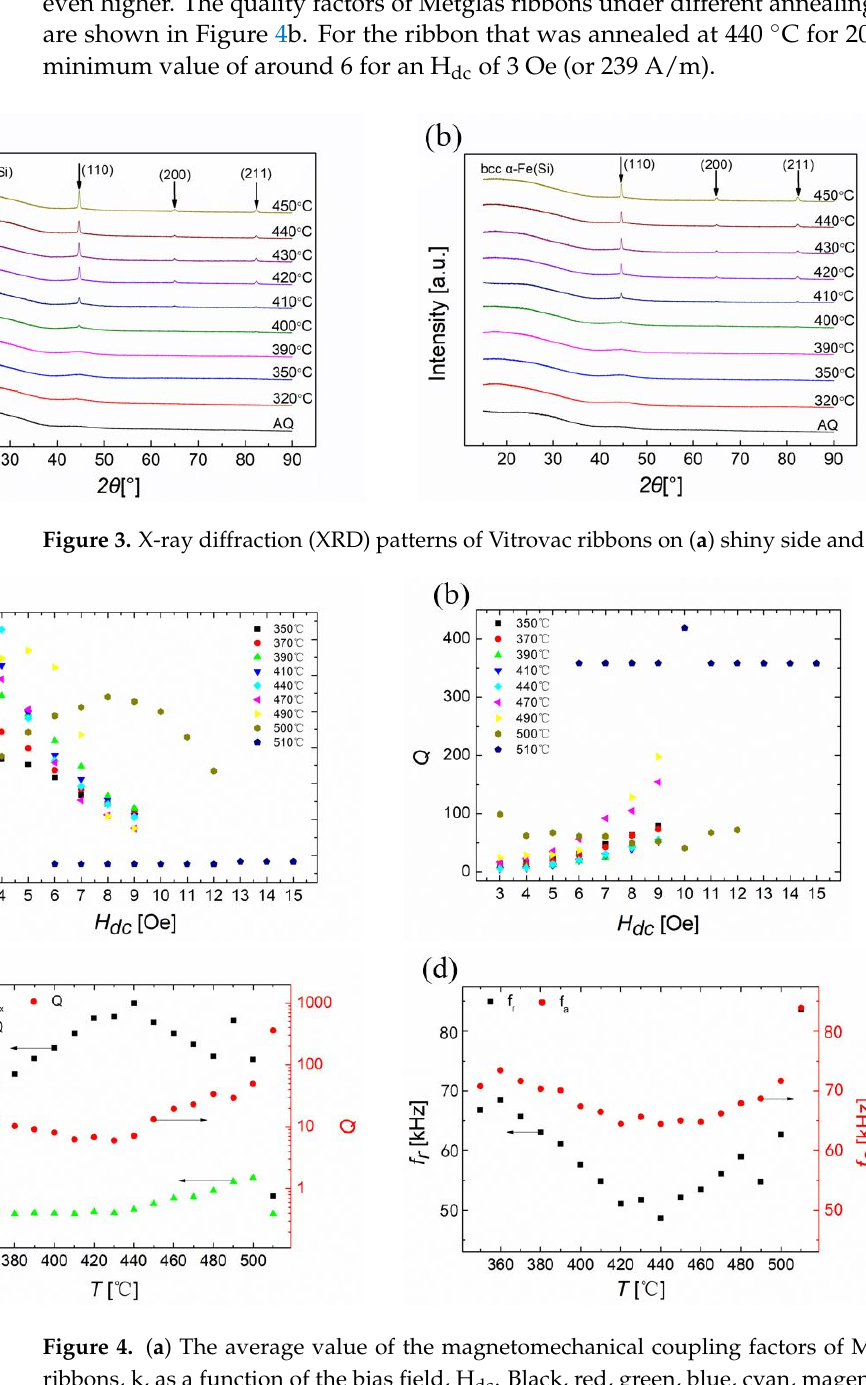
Figure 4. ( a ) The average value of the magnetomechanical coupling factors of Metglas 2605SA1 ribbons, k, as a function of the bias field, H dc . Black, red, green, blue, cyan, magenta, yellow, dark yellow, and navy curves are annealed at 350 °C, 370 °C, 390 °C, 410 °C, 440 °C, 470 °C, 490 °C, 500 °C, and 510 °C for 20 min, respectively. ( b ) The average value of the quality factors of Metglas ribbons, Q, as a function of the bias field, H dc . Black, red, green, blue, cyan, magenta, yellow, dark yellow, and navy curves are annealed at 350 °C, 370 °C, 390 °C, 410 °C, 440 °C, 470 °C, 490 °C, 500 °C, and 510 °C for 20 min, respectively. ( c ) The maximum value of coupling coefficient of Metglas ribbons, k, as a function of the annealing temperature, T. The green and red curves represent the values of the quality factors and efficiency coefficients corresponding to the maximum values of coupling coefficients, respectively. ( d ) The resonance frequencies, f r , and anti-resonant frequencies, f a , associated with the maximum coupling factors, as a function of the annealing temperature.